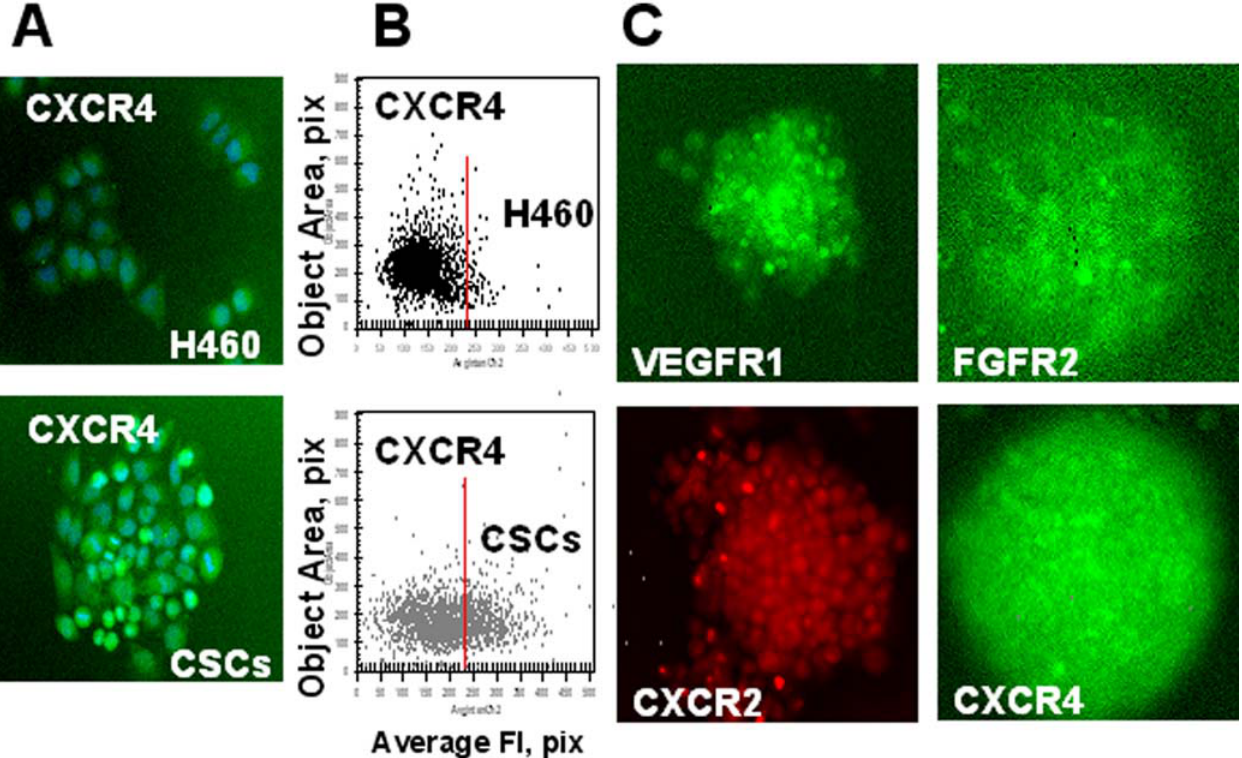
Figure 10. Expression of growth factor and chemokine receptors in lung CSCs. A, B , H460 cells and lung CSCs dissociated from spheres were plated into 96-well plates precoated with Collagen IV and cultured 8 h. Then adherent cells were immunofluorescently stained for CXCR4 (SDF-1 receptor); images were acquired using the Cellomics ArrayScan HCS Reader (20X objective) and analyzed using the Target Activation BioApplication Software Module. A. Immunofluorescent images of CXCR4 in H460 and CSCs cells. B. Fluorescence intensity (pix) of CXCR4 is plotted against object area. C. Expression of growth factor and chemokine receptors in lung CSCs growing in tumor spheres. Lung tumor spheres were immunofluorescently stained for VEGFR1; FGFR2, CXCR1 and CXCR4 receptors; images were acquired using the Cellomics ArrayScan HCS Reader (10X objective). Immunofluorescent images of lung tumor spheres stained for VEGFR1, FGFR2, CXCR1 and CXCR4 are presented.